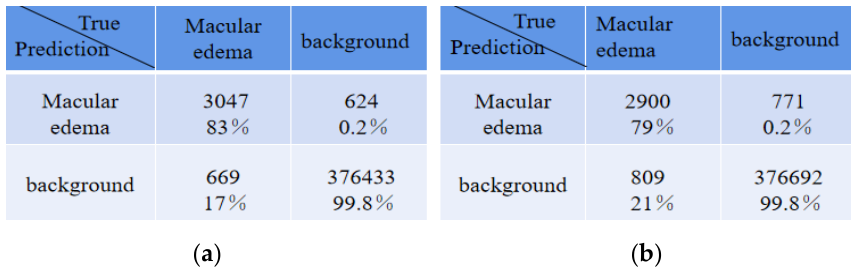
Figure 13. Comparison of segmentation results around fovea edema: ( a ) original image; ( b ) expert 1 annotations; ( c ) expert 2 annotations; ( d ) ReLayNet predictions; ( e ) proposed method predictions.